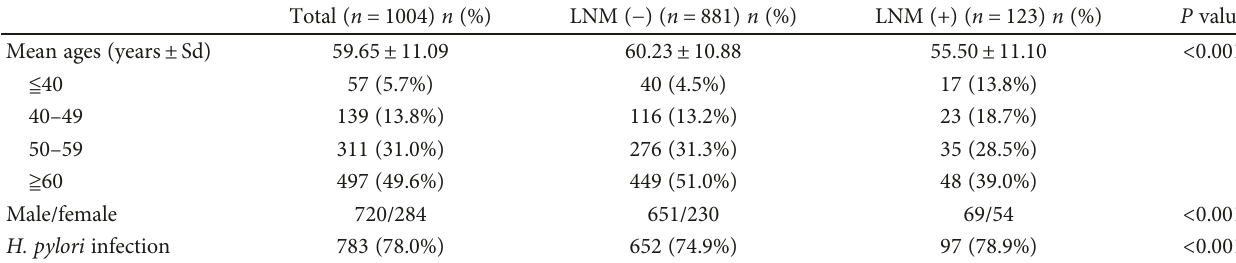
Table 1: Clinical characteristics of the included patients.